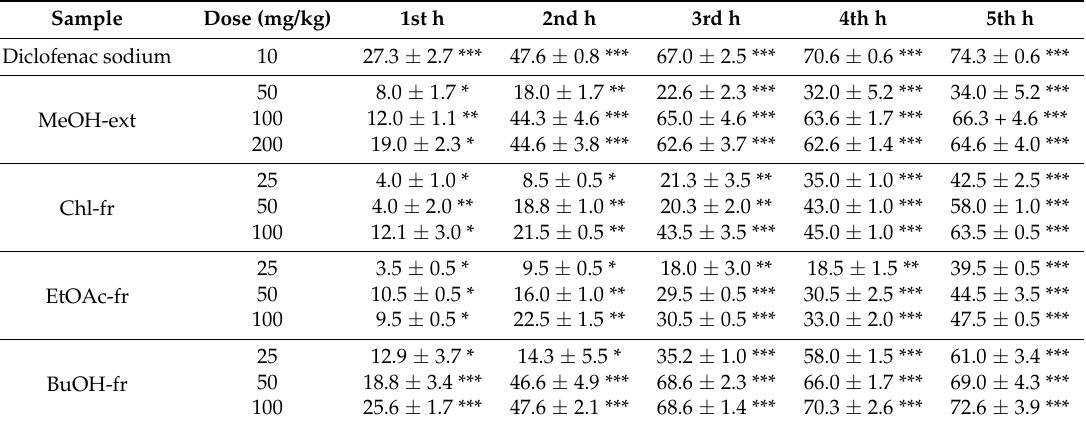
Table 3. Anti-inflammatory activity of Trillium govanianum rhizome methanol extract and fractions in carrageenan-induced paw edema assay.